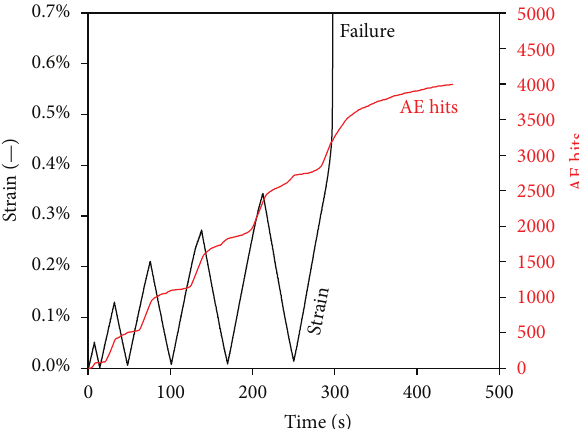
Figure 3: Strain and AE cumulative history for specimen